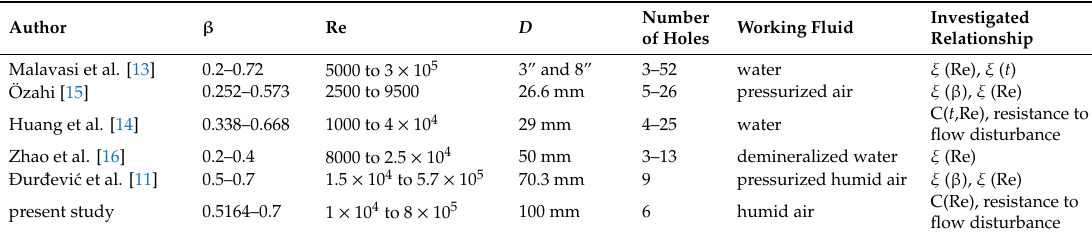
Table 1. Summary of experimental research regarding multi-hole orifices compared with the present